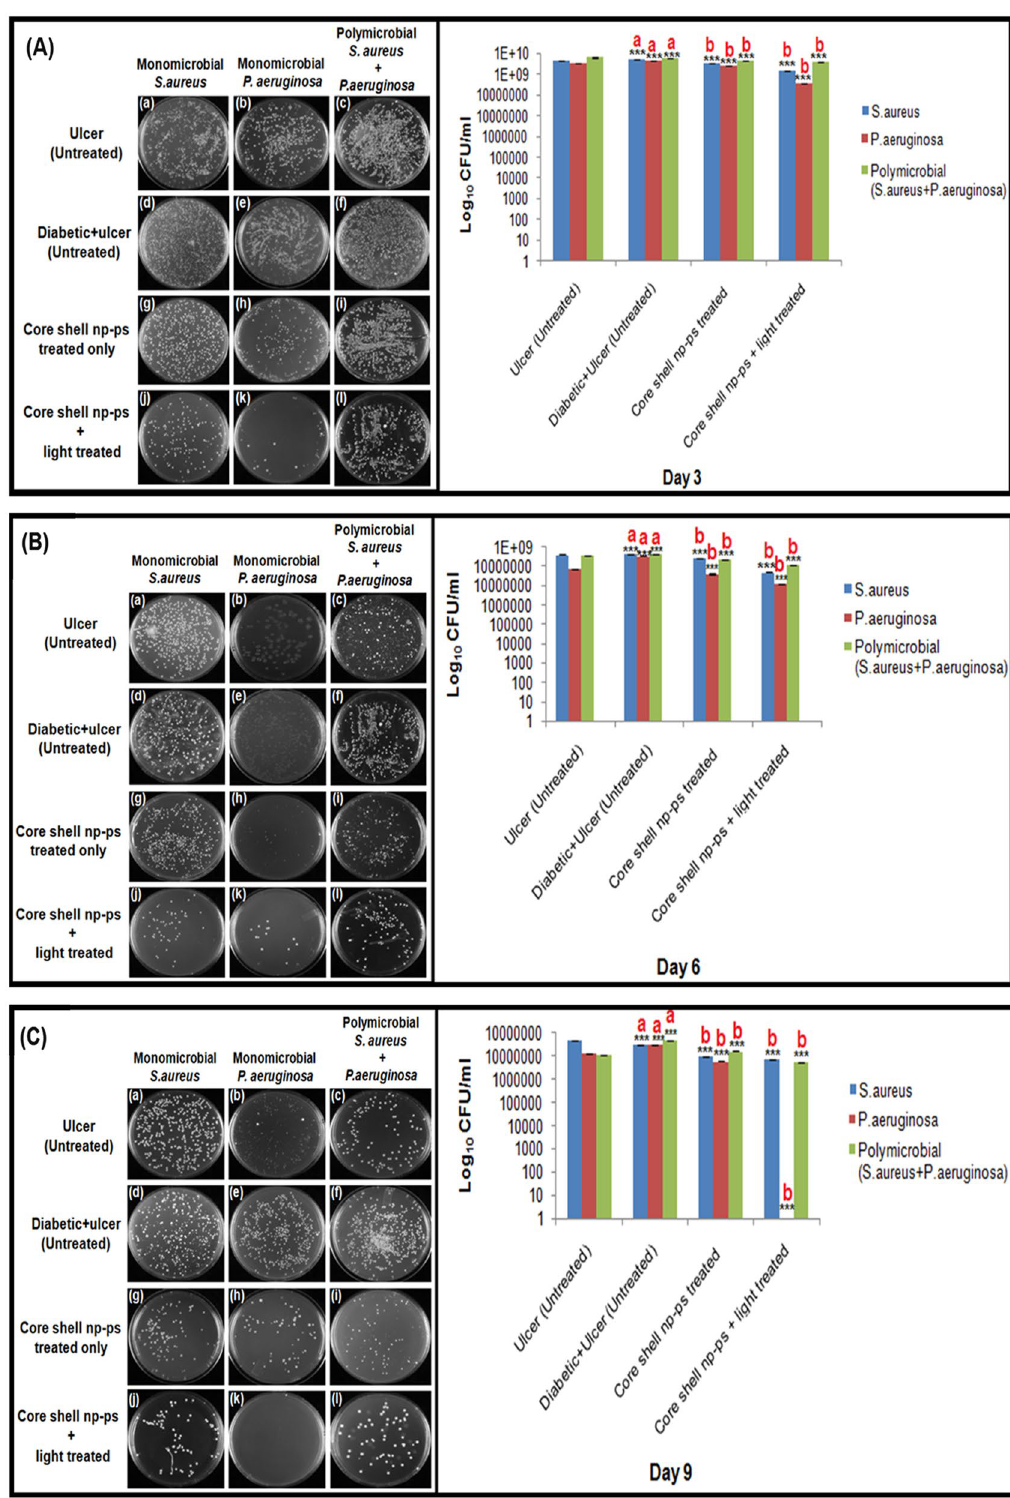
Figure 10. In vivo antibacterial effect of TBO–chit–Au–AgNPs mediated photodynamic therapy in DFU rats: ( A ) CFU/ml at day 3 post ulceration, ( B ) CFU/ml at day 6 post ulceration and treatment, ( C ) CFU/mL at day 9 post ulceration and treatment. Data are presented as mean ± SD (n = 4) and normalized to that of untreated control. Three replicates were performed for each experiment. Statistical significance was determined using one-way analysis of variance ( p -value * p < 0.01, ** p < 0.001, *** p < 0.0001, ns = not significant). a—compared with untreated ulcer; b—compared with untreated diabetic foot